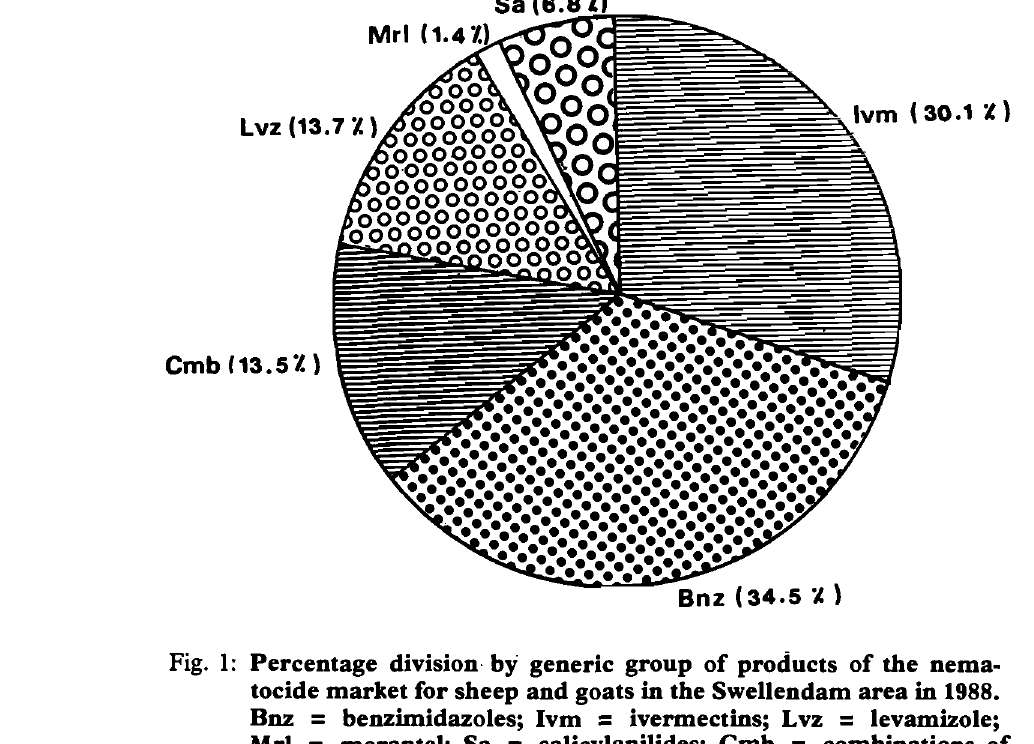
Fig. 1: Percentage division- by' generic group of products of the nema· tocide market for sheep and goats in the Swellendam area in 1988.